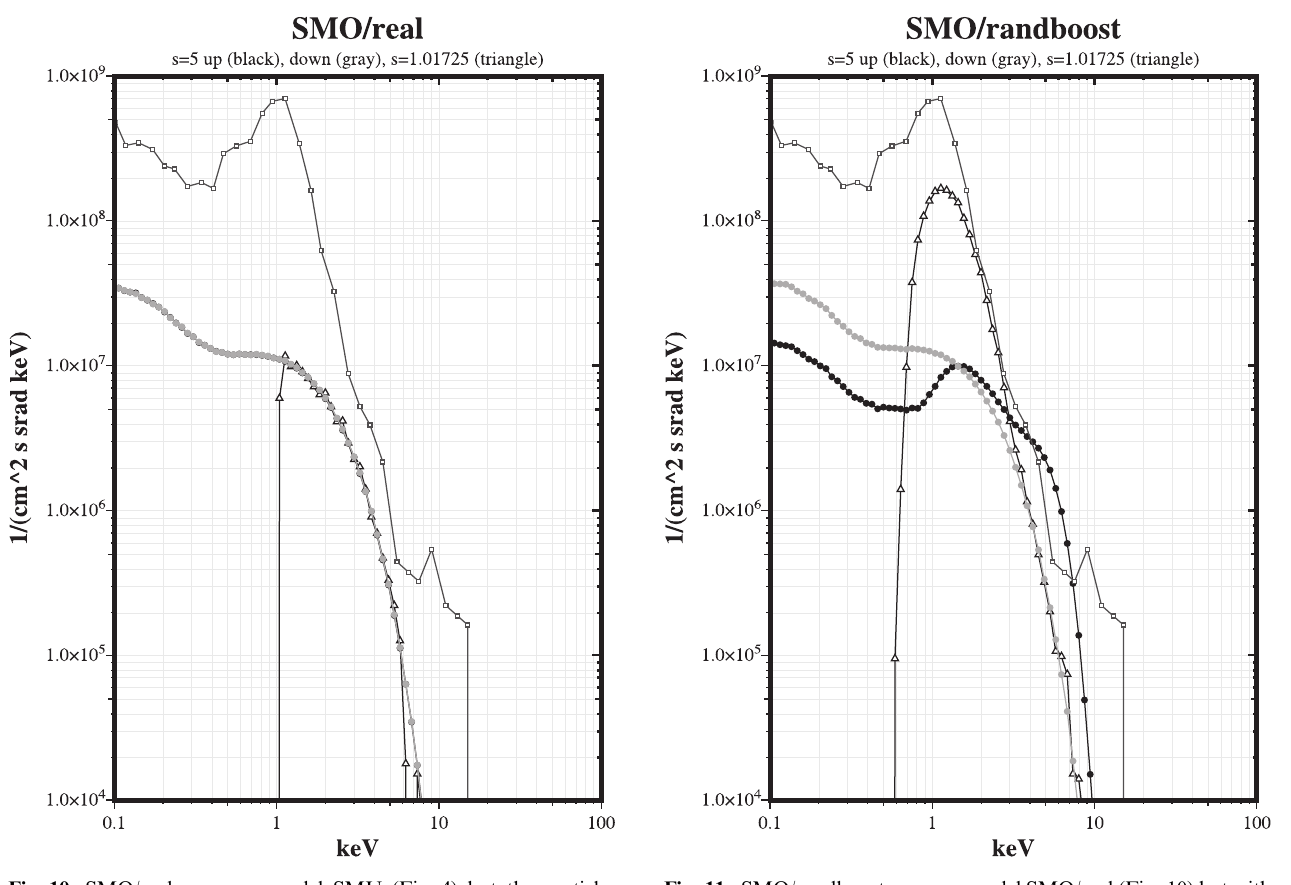
Fig. 10. SMO/real: same as model SMU (Fig. 4) but the particles now move through an O-shaped potential barrier instead of the U-shaped potential drop. The peak is much too low